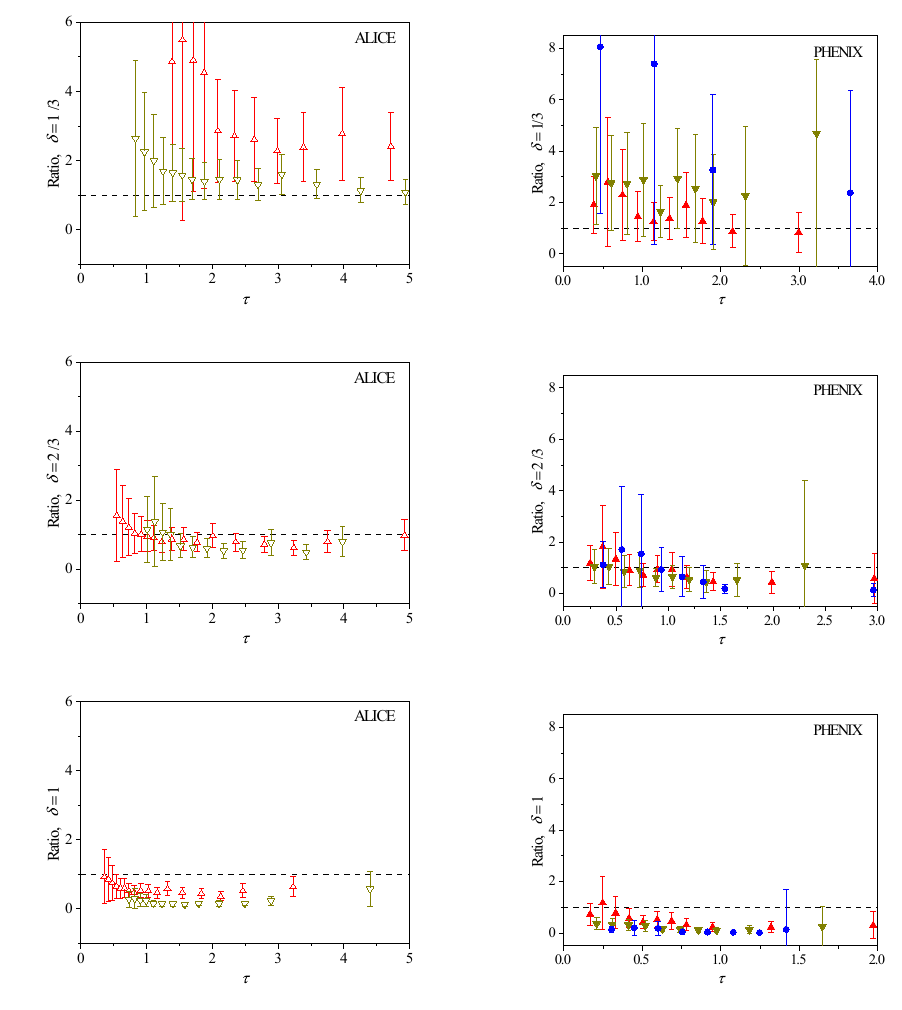
Figure 6. Illustration of geometrical scaling of the (cid:13) yields in heavy ion collisions at di (cid:11) erent centrality classes. Left panel: ALICE. Red triangles correspond to R c panel: PHENIX. Red triangles points correspond to R c R c . Upper plot (cid:14) = 1 = 3, middle plot (cid:14) = 2 = 3 and the lower plot (cid:14) = 1. 1 = c 4